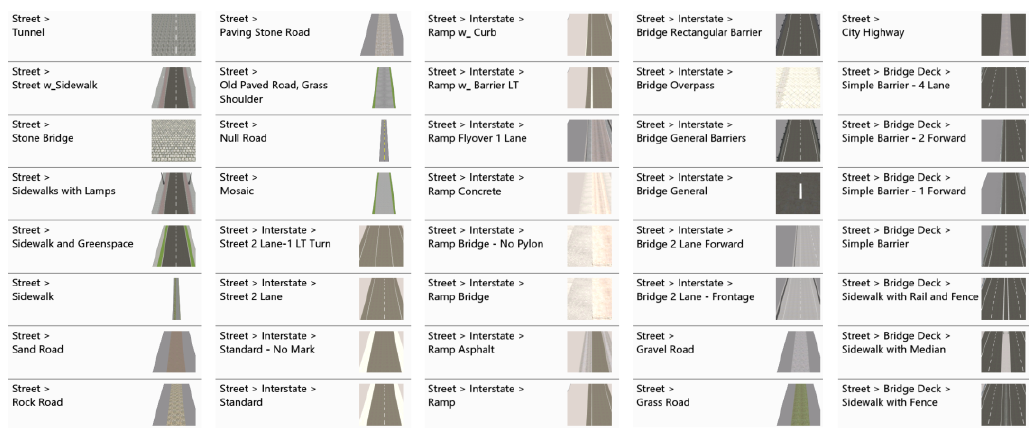
Figure 1. Typical road objects available as parametric elements for Building Information Modeling (BIM) in Autodesk InfraWorks ® (AIF).